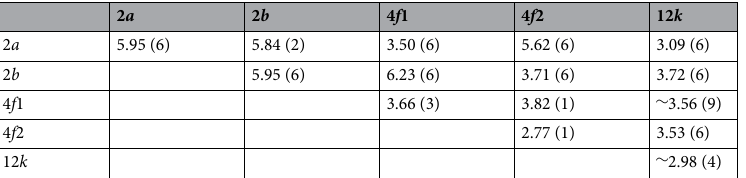
Table 1. Nearest neighbours distances in Å and number of nearest neighbor ions, z ij , in parenthesis, for the five Fe-sublattices, obtained for the theoretically optimized SFO lattice constants.